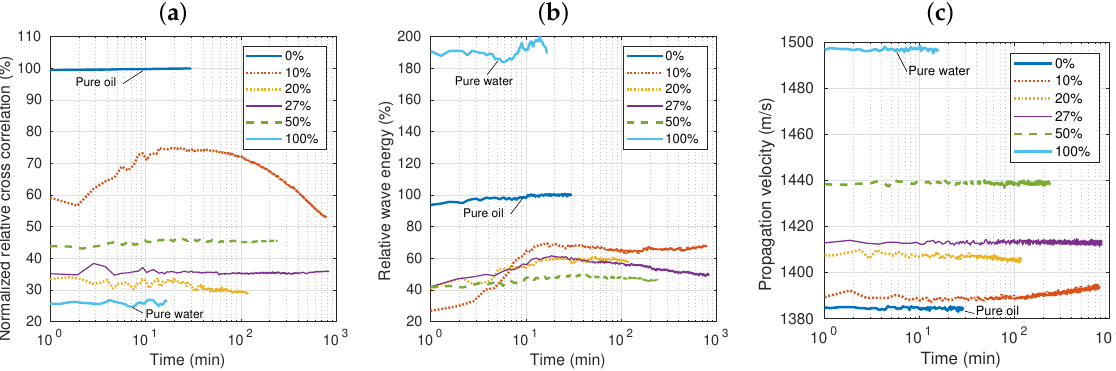
Figure 3. Experimental results of the long-term test at 22 ± 0.2 ◦ C: the relative cross-correlation ( a ), relative wave energy ( b ), and propagation velocity ( c ) as a function of